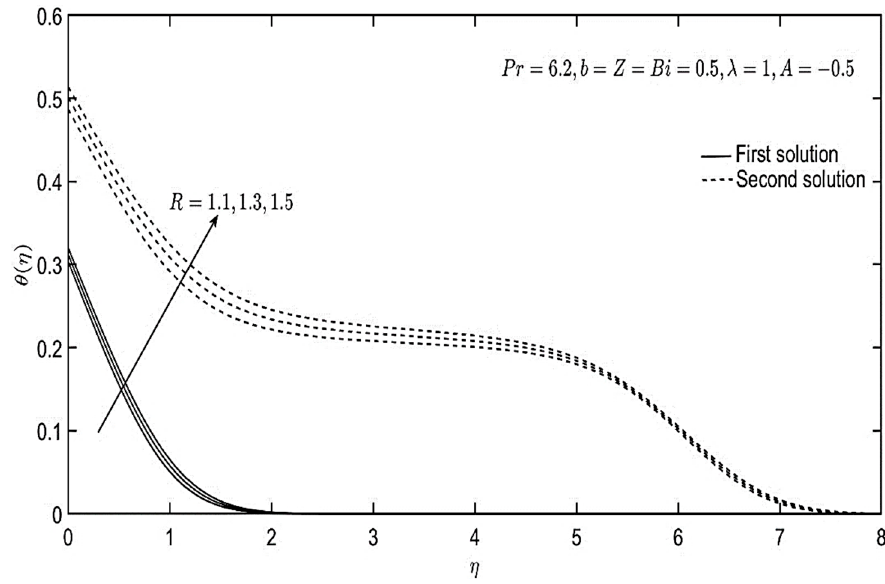
Figure 10. Temperature distributions for various values of 𝑅 .